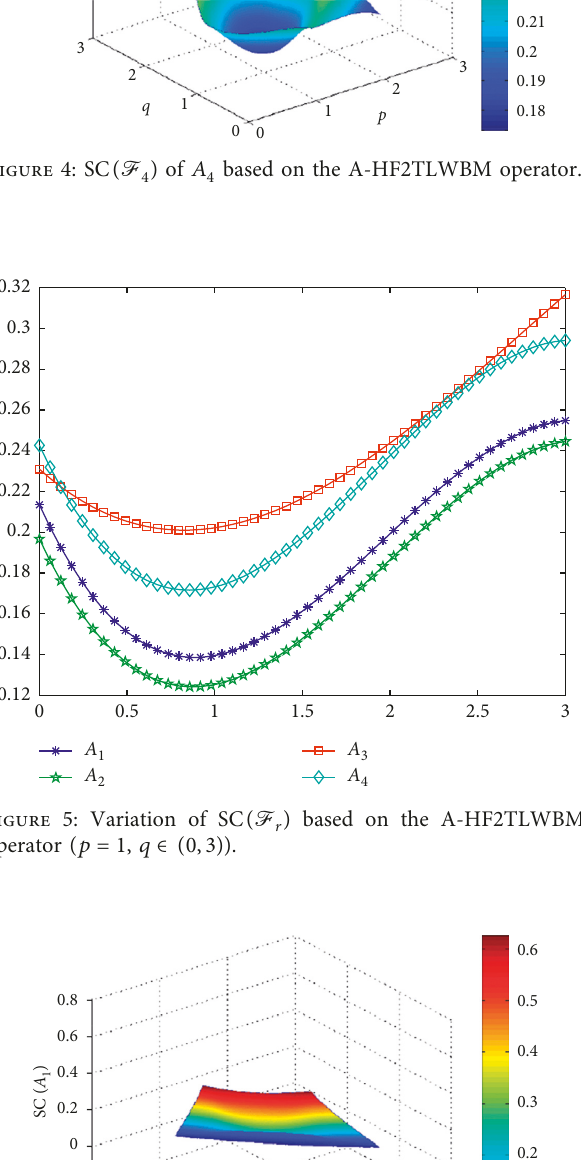
) of A based on the A-HF2TLWBM 3 3